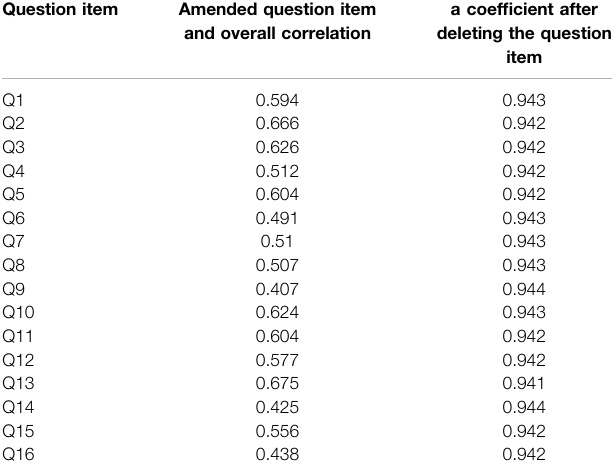
TABLE 3 | Item-to-total correlation statistics results.